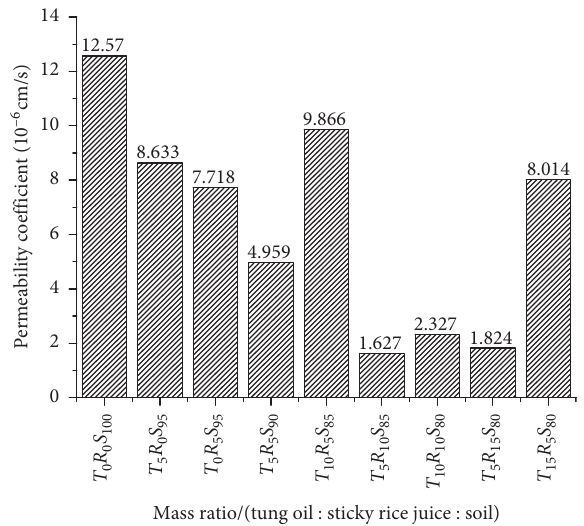
Figure 8: Permeability coefficients of the treated soil